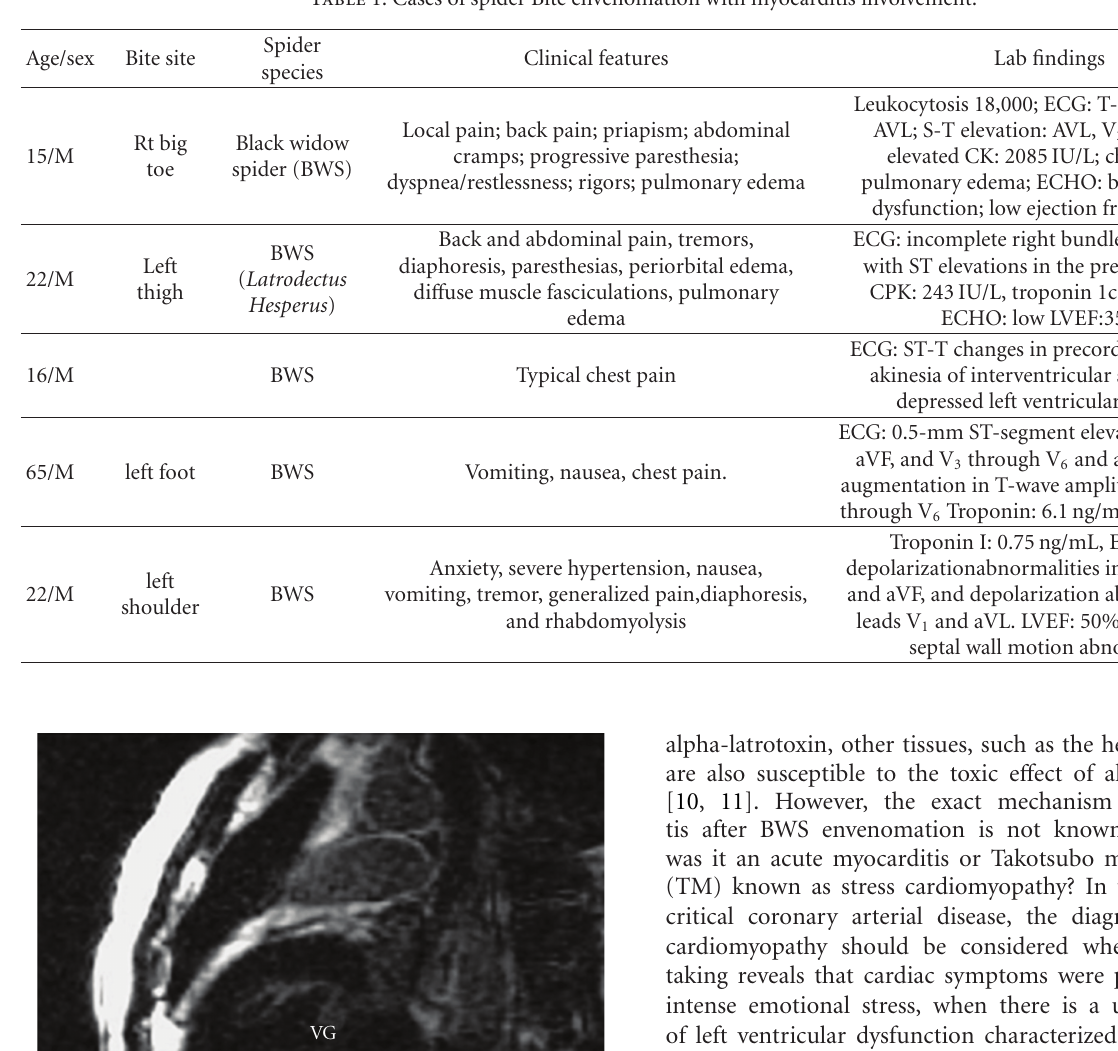
Table 1: Cases of spider Bite envenomation with myocarditis involvement.